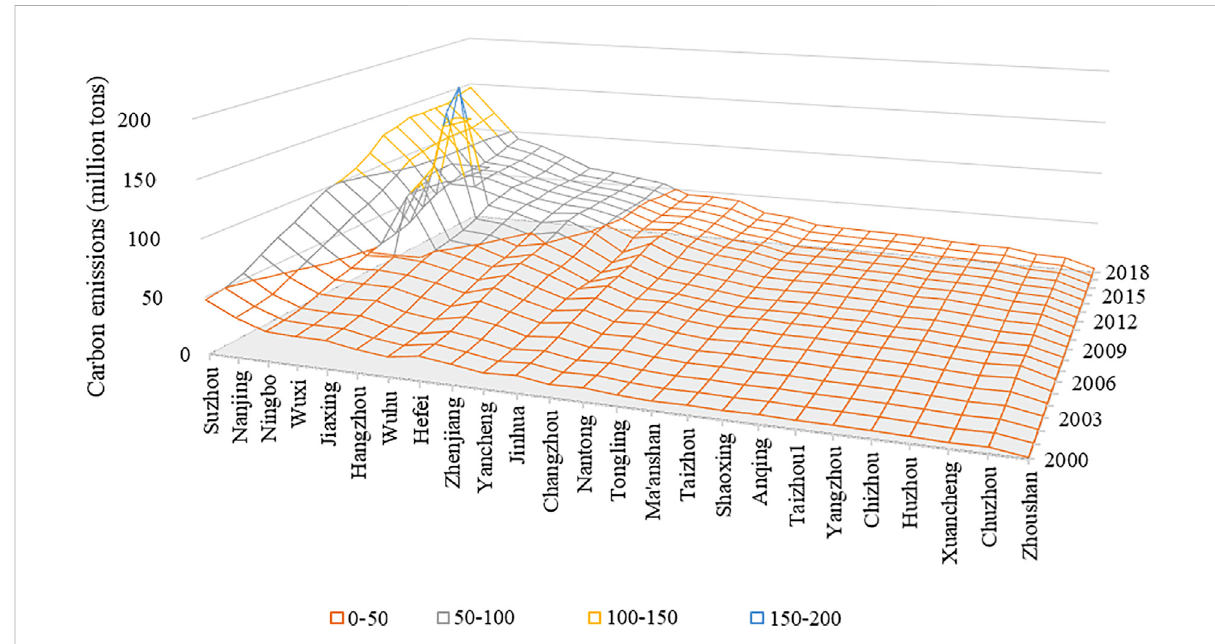
FIGURE 4 Trends in carbon emissions in 26 cities in the Yangtze River Delta region, 2000 –